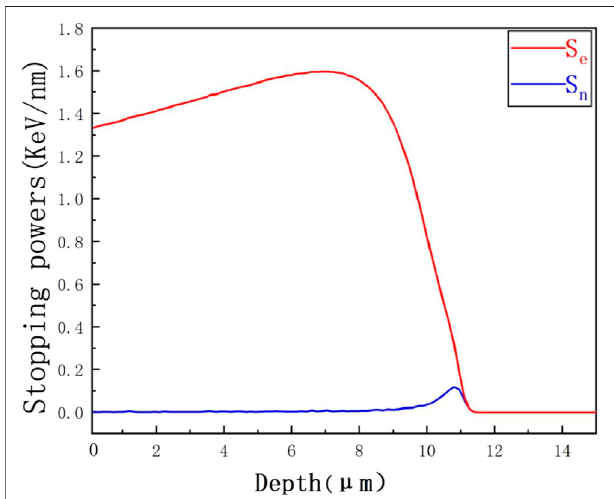
FIGURE 1 | Electronic (red line) and nuclear (blue line) stopping powers as function of penetrate depth from the surface of the 15 MeV C 5+ ion irradiated BaF 2 crystal.